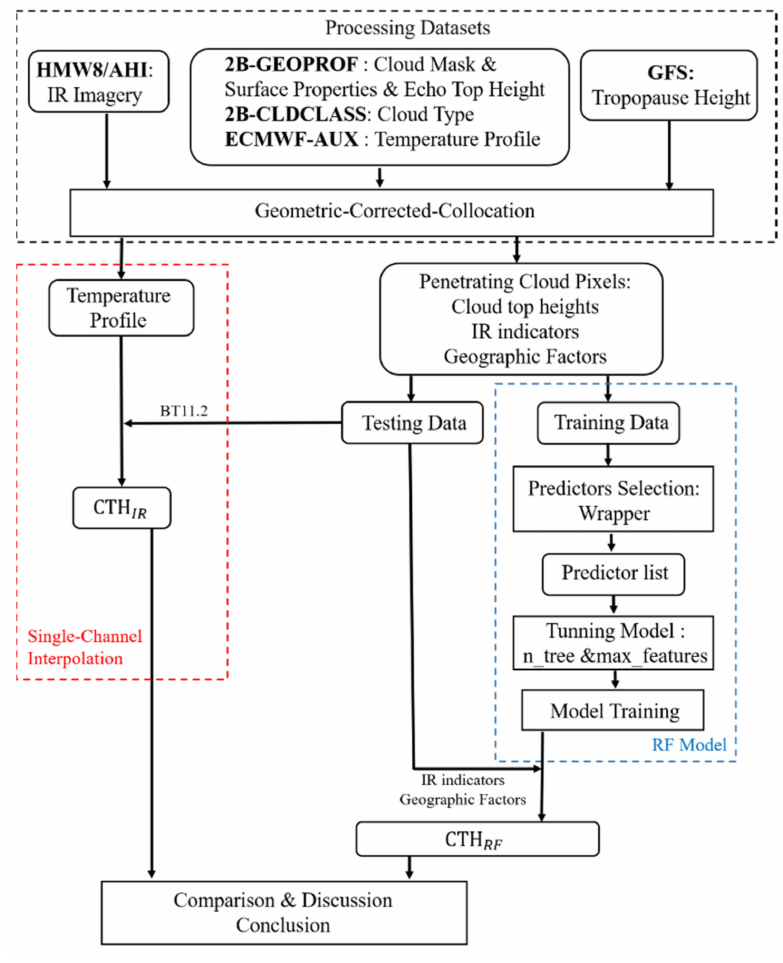
Figure 1. The workflow of this